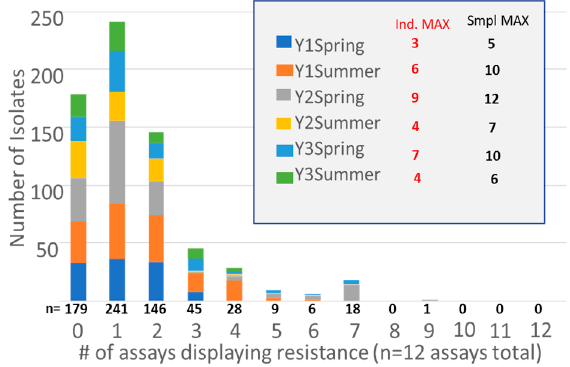
Figure 4. Number of multiple drug resistant (MDR) isolates, based on results of disk diffusion assays for 12 drugs. Bars display number of isolates with the listed number of resistances, 0–12. Total number positive across all sample times is listed directly under each bar. “Ind. MAX” indicates the maximum number of resistances in any one isolate from the given group. “Smpl MAX” indicates the total number of resistances positive for all isolates of the group (Y1Spring isolates displayed resistance to a total of five different drugs). Only samples that fluoresced in EC+MUG (confirmed as E. coli ) were stamped for resistance patterns. Up to three isolates were picked per sample and media type.